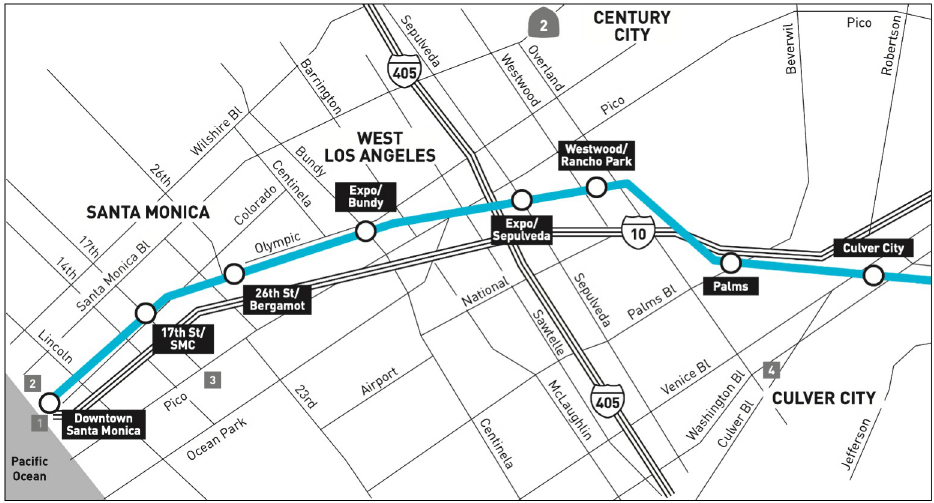
Fig 10. Map of the Metro Expo Line light rail extension to Santa Monica, CA. Operations began on May 20, 2016 at seven new stations, of which four are located within Santa Monica city borders. They are Expo/Bundy, 26 th Street/ Bergamot, 17 th Street/Santa Monica College, and Downtown Santa Monica. The other three stations (Palms, Westwood/Rancho Park, Expo/Sepulveda) are within neighboring Culver City. Prior to May 20, 2016 the, Expo Line’s terminus was at the Culver City train stop. Picture courtesy of the Los Angeles